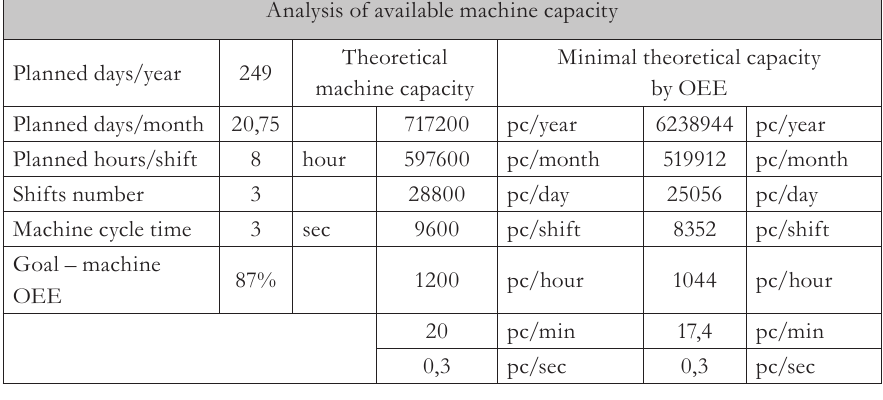
Tab. 3 - Example of algorithm setting for selected type of a process situation – identification of mo- tivation parameters for workers as a basis for financial and non-financial motivation of